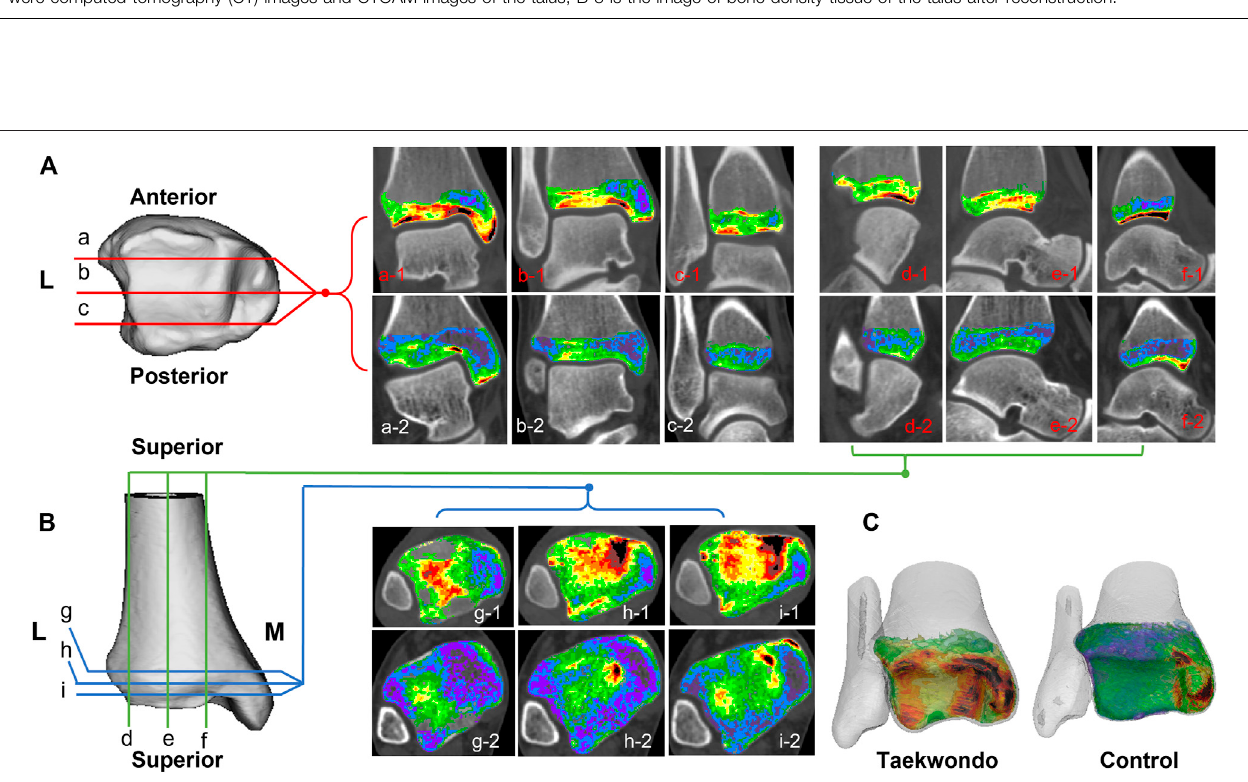
FIGURE 2 | Computed tomographic images of the distribution of different bone density bone tissues in the distal tibia in two groups. (A) is a schematic diagram of the coronal tomographic images of the tibia; (B) is a schematic diagram of the sagittal and axial tomographic images of the talus; (C) is a schematic diagram of the superimposed bone tissueofeach bonedensity withinthedistaltibia.a1 – c1arethecoronal imagesoftheTaekwondo; d1 – f1arethesagittalimages oftheTaekwondo; g1 – i1 are the axial images of the Taekwondo; a2 – c2 control coronal images; d2 – f2 control sagittal images; g2 – i2 control axial images.